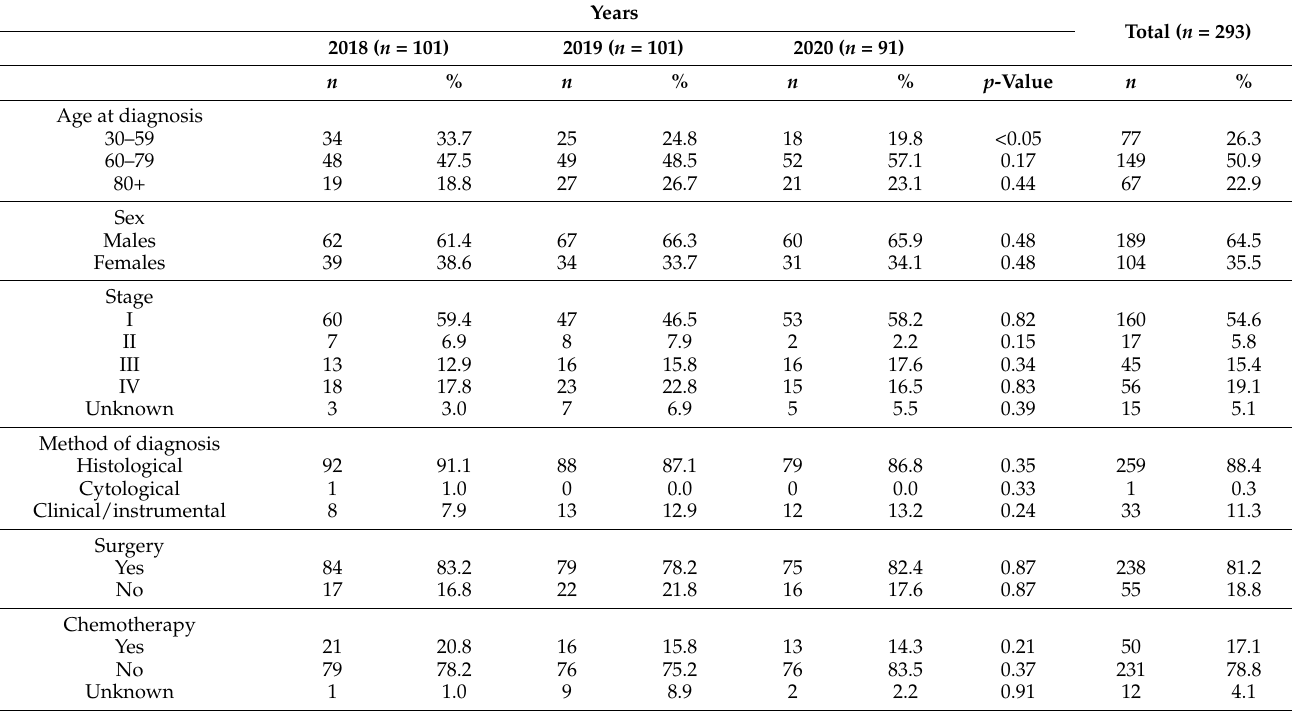
Table 1. Reggio Emilia Cancer Registry. Years 2018–2020. Number of cases by age, sex, stage, method of diagnosis, and therapy, per